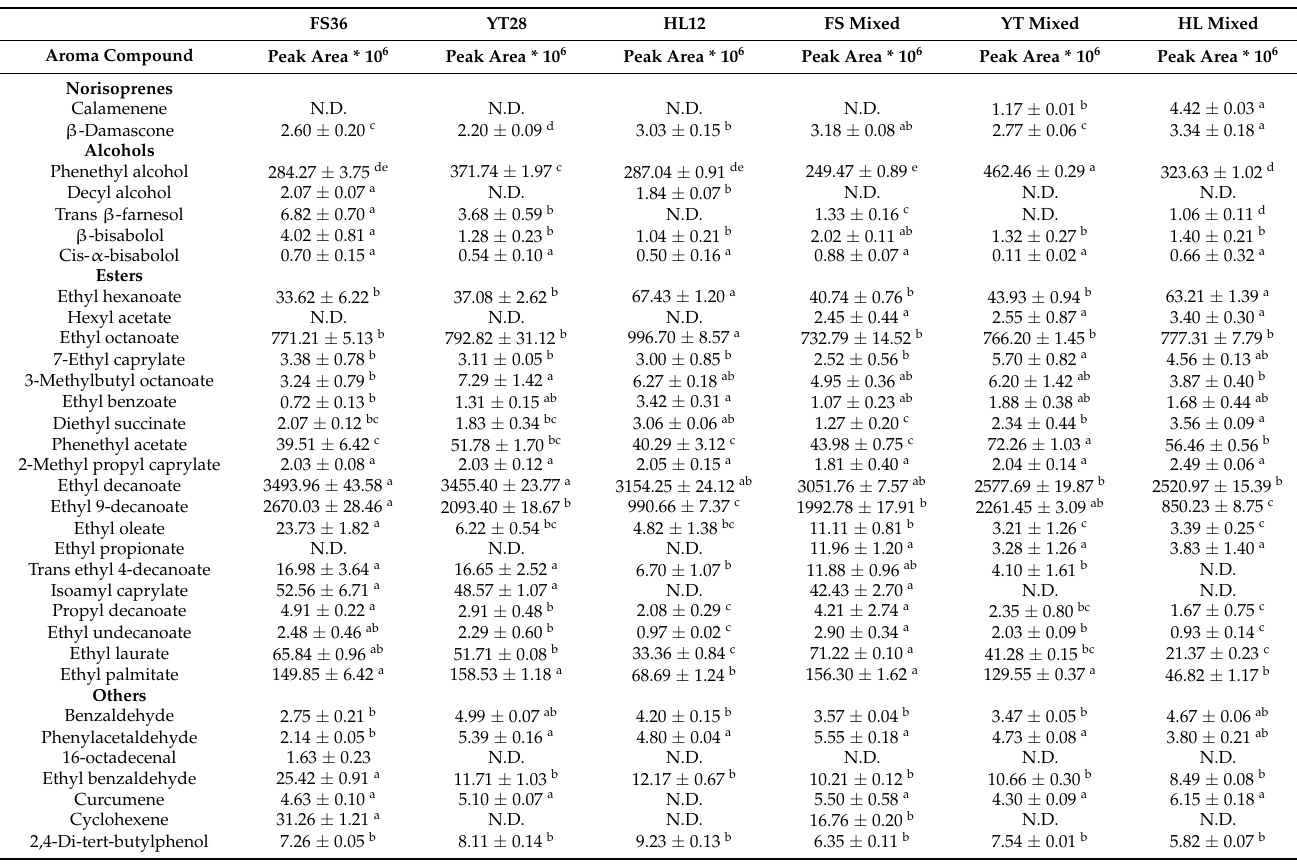
Table 4. The average peak area of volatile aroma compounds of Marselan